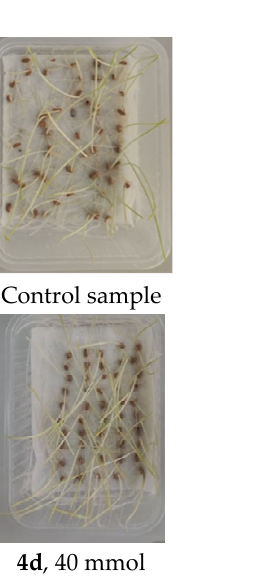
Figure 4. Sowing qualities of wheat seeds.